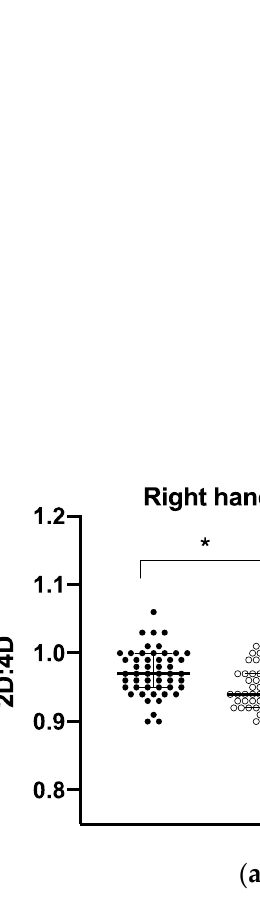
Figure 2. Median and interquartile ranges for right ( a ) and left ( b ) 2D:4D ratios in athletes and non- athletes. Mann–Whitney U test. Results are described in median and interquartile ranges. Athletes, n = 66; non-athletes, n = 51. * p > 0.0001.